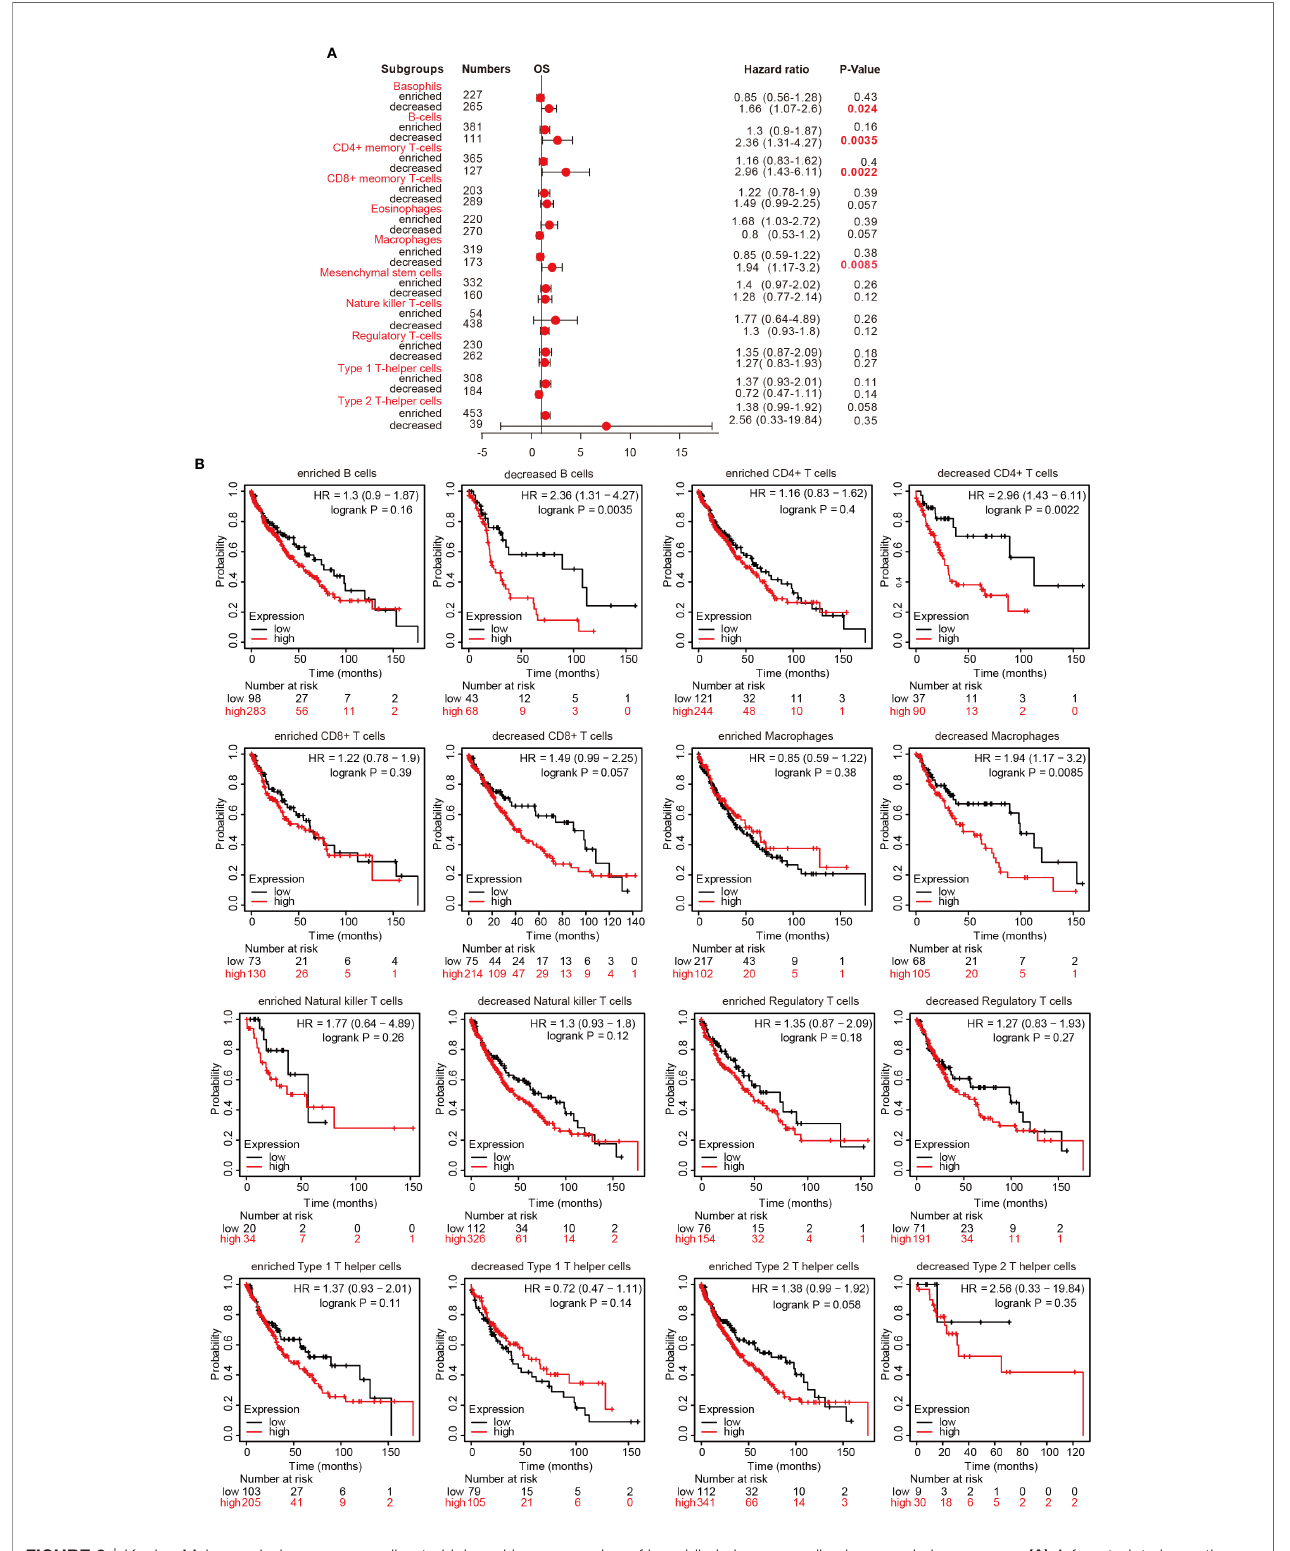
FIGURE 8 | Kaplan-Meier survival curves according to high and low expression of hepcidin in immune cell subgroups in lung cancer. (A) A forest plot shows the prognostic value of hepcidin expression according to different immune cell subgroups in LUSC patients. (B) Correlations between hepcidin expression and OS in different immune cell subgroups in LUSC patients were estimated by Kaplan-Meier